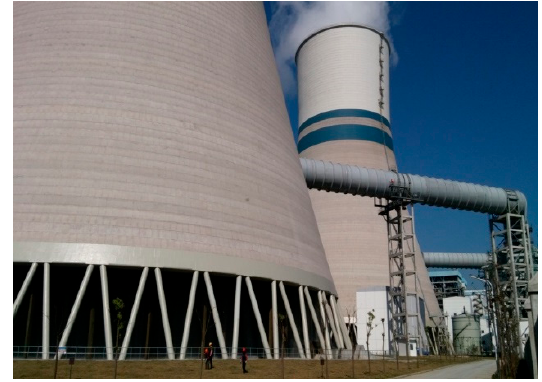
Figure 1. Cooling tower with a flue gas pipe.